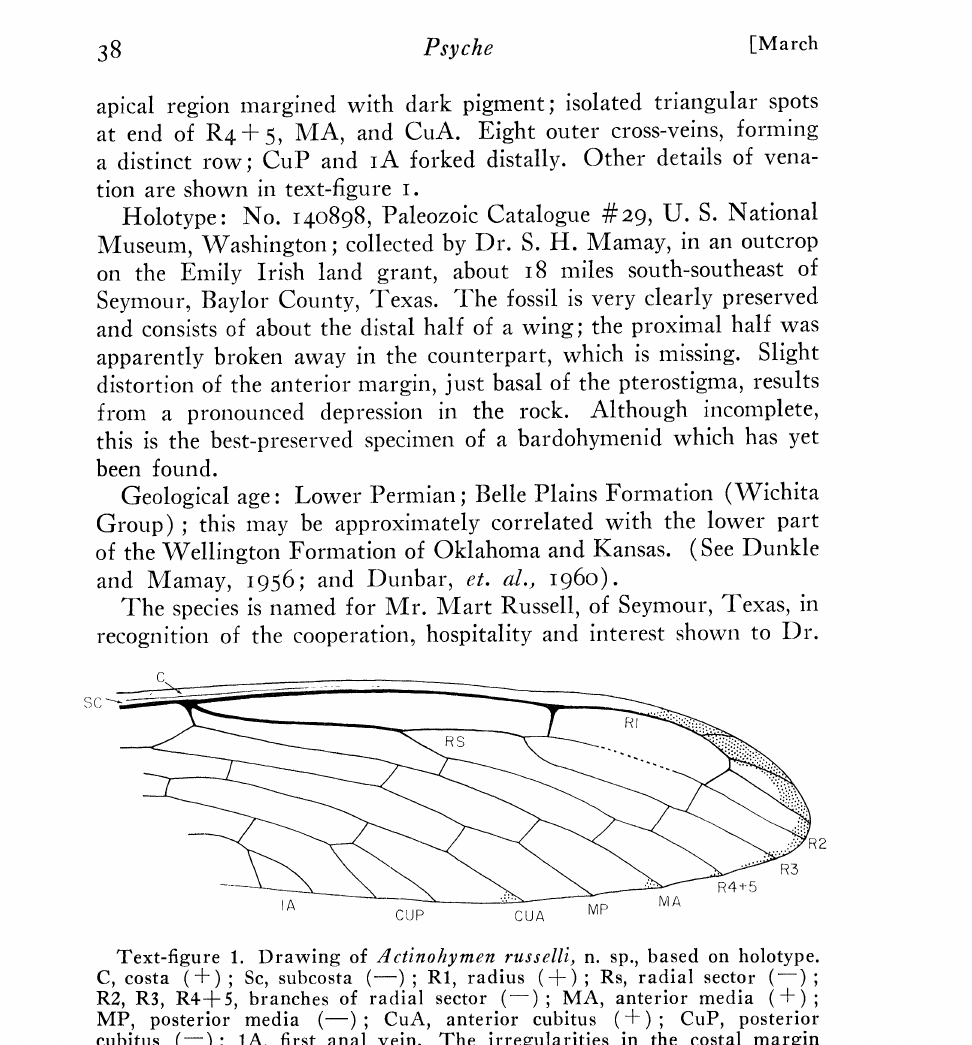
Text-figure 1. Drawing of /lctinohymen russelli, n. sp., based on holotype. C, costa (+); Se, subcosta (--); R1, radius (q-); Rs, radial sector (--); R2, R3, R4q-5, branches of radial sector (--); MA, anterior media (+); MP, posterior media (--); CuA, anterior eubitus (+); CuP,